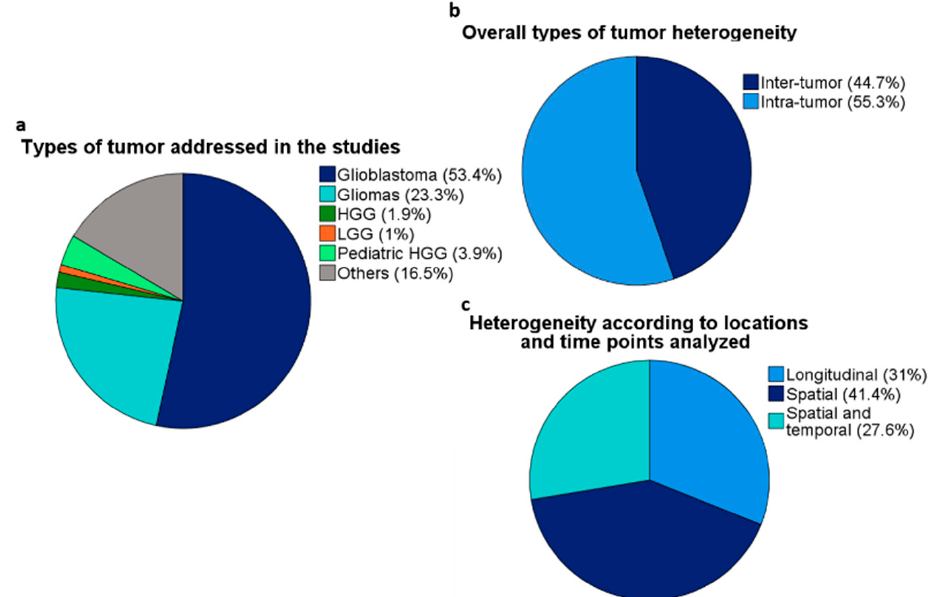
Figure 1. Overall profile of the selected articles cited in the review. ( a ) Type of tumors included in the studies. “Others” includes meningiomas, brain metastases, and other CNS tumors. ( b ) Types of tumor heterogeneity. ( c ) Types of tumor heterogeneity according to the origin of samples and time point of collection. Tumor evolution studies are counted in the “Spatial and temporal” cate- gory.